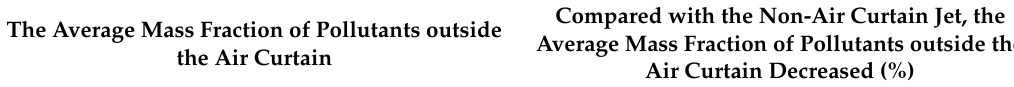
Table 4. Statistical data for pollutants outside the air curtain under different air curtain